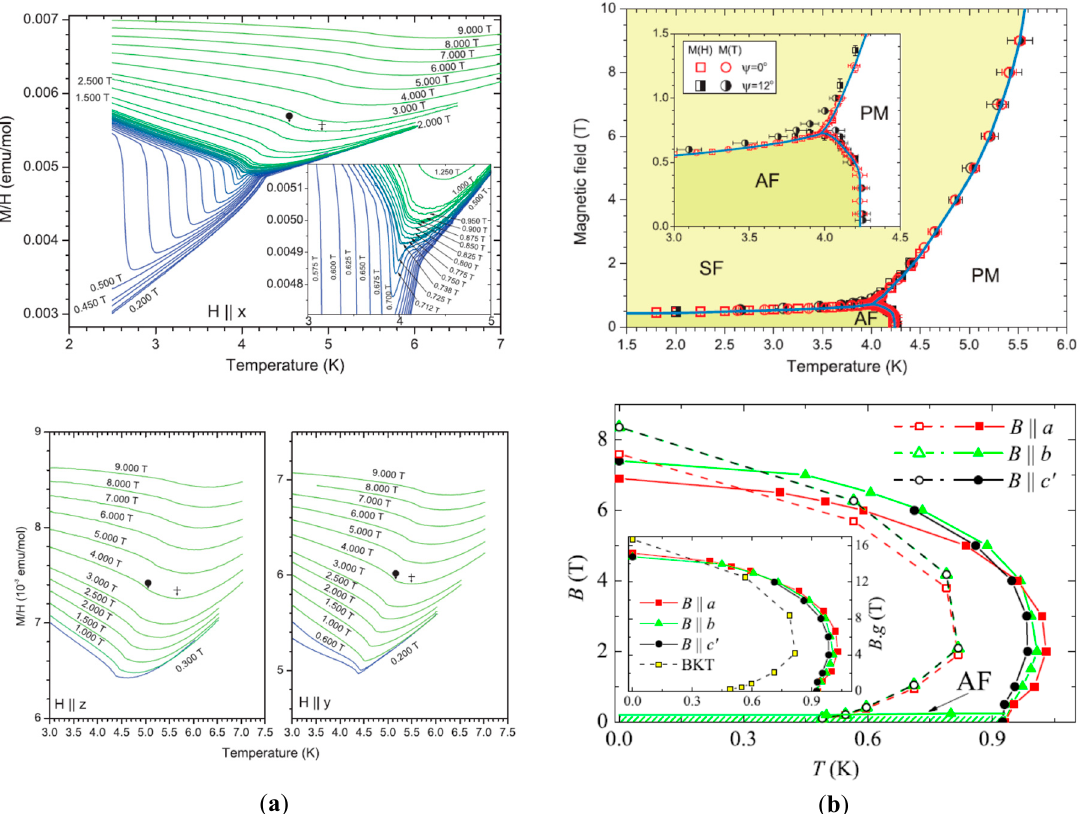
Figure 13. ( a ) (top, bottom) Normalized magnetization M ( T )/ B of Cu(pz) 2 (ClO 4 ) 2 for various magnetic fields B ≡ µ 0 H applied along the easy ( x ), middle ( y ) and hard ( z ) axis. In all three cases, the cross and droplet symbols mark the minimum and kink, respectively. (Reproduced with permission from reference [94]); ( b ) (top) Magnetic phase diagram of Cu(pz) 2 (ClO 4 ) 2 in the field applied along the easy axis. AF, SF and PM denote the collinear antiferromagnetic phase, the spin-flop phase and the paramagnetic phase, respectively. The phase boundaries are constructed from the anomalies in the M ( T ) and M ( H ) curves, red and black points correspond to the orientation of the field ( ψ = 0 ◦ and 12 ◦ ) with respect to the easy axis. Lines are a guide to the eye. In the inset, an expanded region around the bicritical point is shown. (Reproduced with permission from reference [94]); ( b ) (bottom) Magnetic phase diagram of Cu(en)(H 2 O) 2 SO 4 . The a , b , c (cid:48) axes correspond to the hard, easy and middle axis, respectively. Open symbols represent the theoretical predictions [97] for a field-induced BKT transition in the S = 1/2 HAF square lattice ( R = 1, J / k B ≡ J eff / k B = 2.8 K, g a = 2.200, g b = 2.005 and g c (cid:48) = 2.000). Inset: the same diagram, B is replaced by the product B · g . (Reproduced with permission from reference